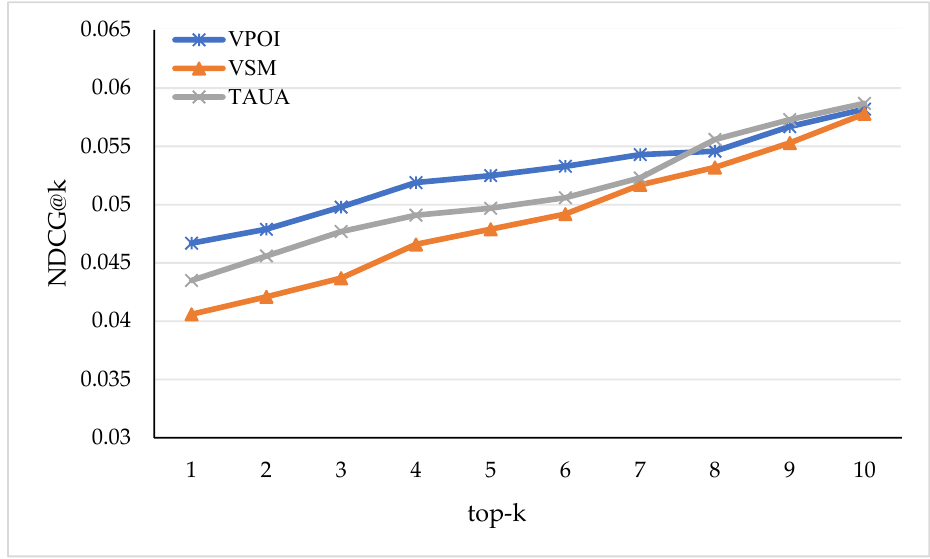
Figure 7. Top-k image recommendations NDCG@k performance comparison on Amazon datasets.